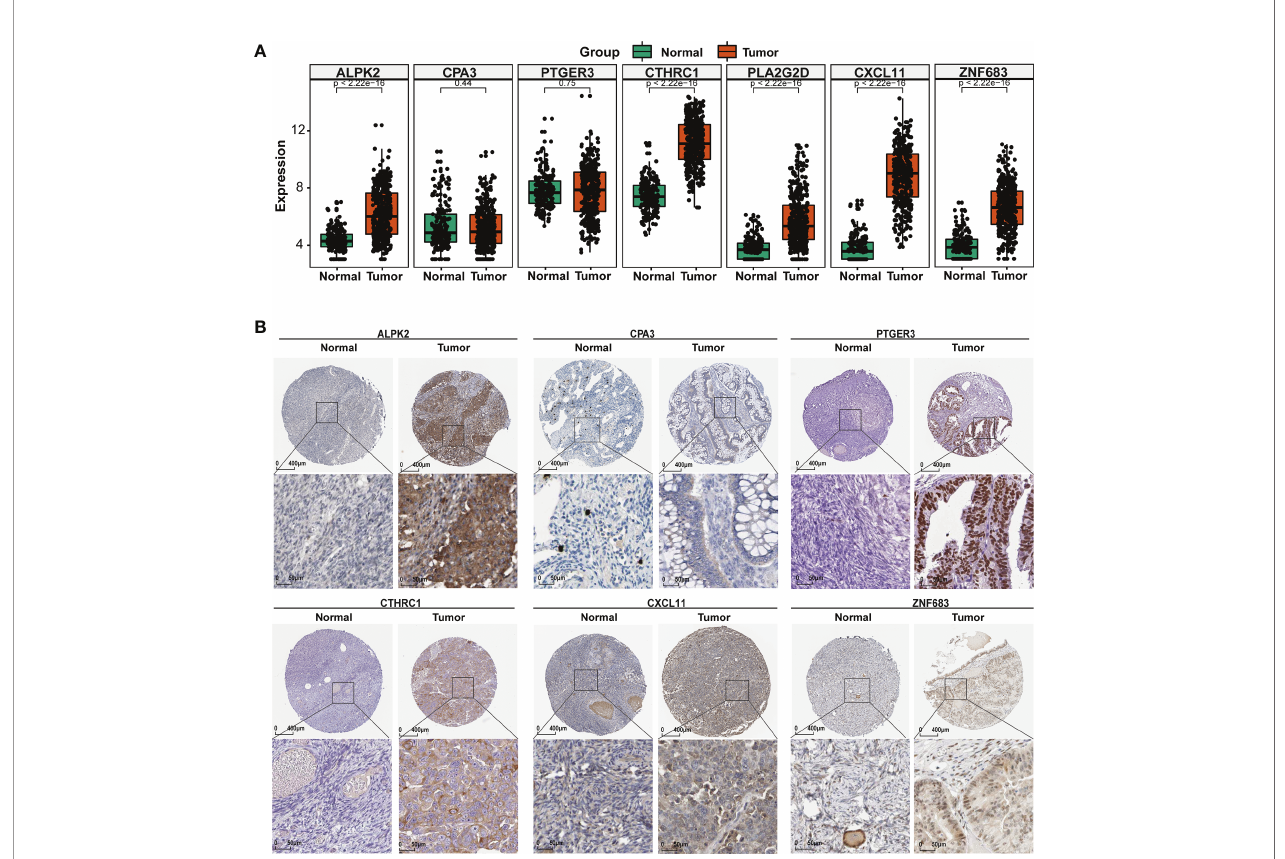
FIGURE 5 | TME regulators are associated with EOC clinical characteristics. (A) Differential analysis of the mRNA expression of the seven TIME regulators between the normal ovary and OC tissues. (B) The protein expression of the seven TIME regulators in normal ovary and OC tissues using the HPA